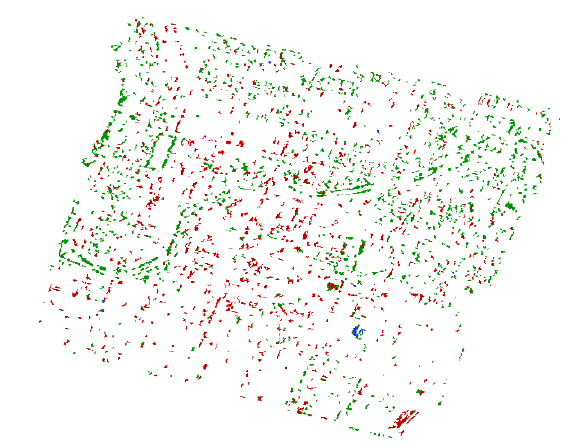
Figure 7 . Christchurch test area: predicted classes debris (red), vegetation (green) and gravel (blue) for a closed world scenario.